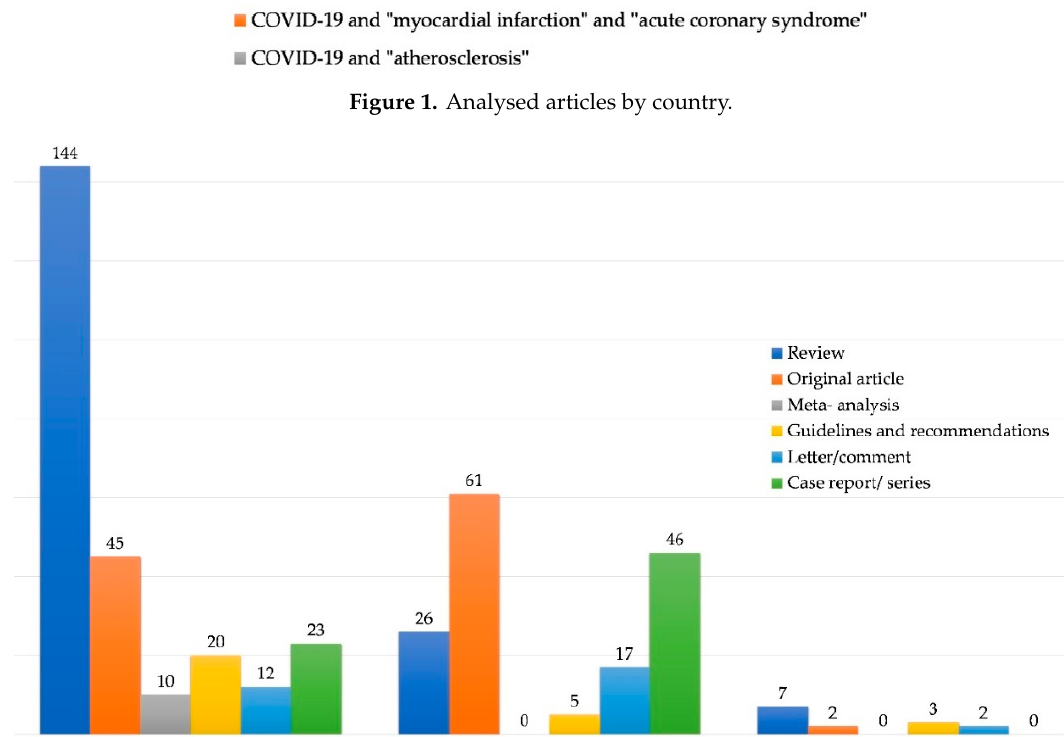
Figure 2. Types of articles analysed by search words.